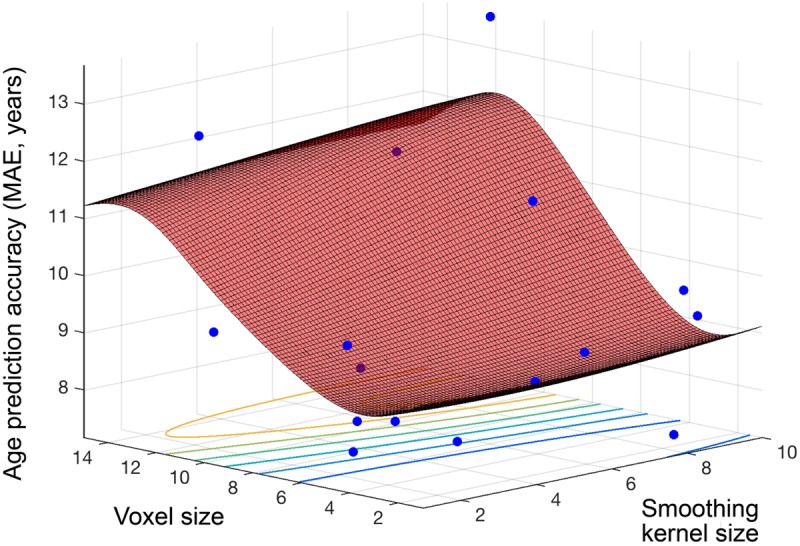
Objective function model for age prediction. Objective function model resulting from optimizing during regression for exact age prediction. The red surface is the function model and represents performance at each location. Points where the parameter space was sampled are shown (blue).